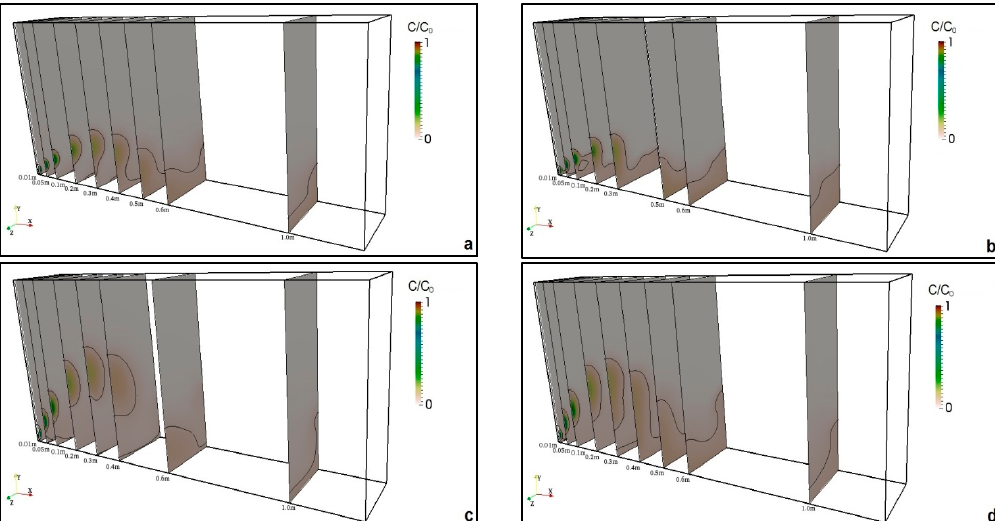
Figure 5. Discharge growth width at various cross-sections: the contour lines represent S = C 0 / C = 1 (Source: [25]). ( a ) 30°, realizable k- ε ; ( b ) 30°, LRR; ( c ) 45°, realizable k- ε ; ( d ) 45°, LRR.